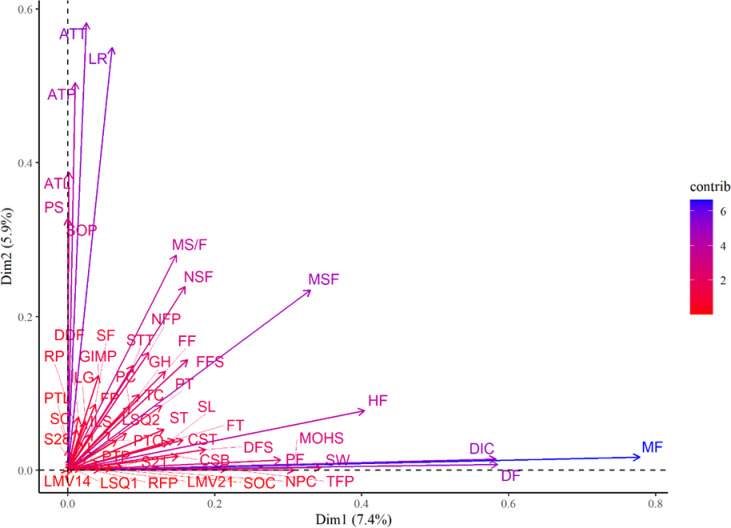
Dispersion of quantitative and multi-categorical characteristics in relation to the first two components: Leaf SPAD index at 21 days after transplanting (S21) and at 28 days (S28); Length of Main Vine at 14 days after transplanting (LMV14) and at 21 (LMV21); accumulated Degree-Days for Flowering (DDF); Number of Fruits per Plant (NFP); average Mass of Fruits (MF); Productivity of Fruits (PF); Height of Fruit (HF); Diameter of Fruit (DF); Thickness of Fruit Peel (TFP); Resistance of Fruit peel to Penetration (RFP); Resistance of fruit pulp to Penetration (RP); thickness of fruit pulp (PT); Diameter of Internal Cavity of fruit (DIC); Total Content of fruit pulp carotenoids (TC), and Lutein (L); Number of Seeds per plant (NSF); Mass of Seeds per Fruit (MSF); ratio of seed to fruit mass (MS/F); Mass of one Hundred Seeds (MOH); Productivity of Seeds (PS); Seed Thickness (ST); Seed Length (SL); Seed Width (SW); Seed Oil Content (SOC); Seed Oil Productivity (SOP).Growth habit (GH); stem colour (SC); intensity of leaf green (ILG), leaf silvering (LS), intensity of leaf silvering (ILS); leaf serration (LS); presence of trichomes in the leaves (PAL); amount of trichomes in the adaxial surface of leaves (ATT); amount of trichomes in the abaxial surface of leaves (ATL); leaf recess (LR); presence of trichomes in the petiole (PTP); amount of trichomes in the petiole (ATP); green intensity of male pedicel (GIMP); format of fruits (FF); format of peduncle (FP); number of colours of fruit peel (NPC); topography of fruit surface (FT); format of floral scar (FFS); peel texture (PT); predominant colour of fruit peel (PC); depth of fruits slices (DFS); seed format (SF); aspect of seed tegument (AST); seed tegument texture (STT); colour of seed tegument (CST); colour of seed border (CSB).